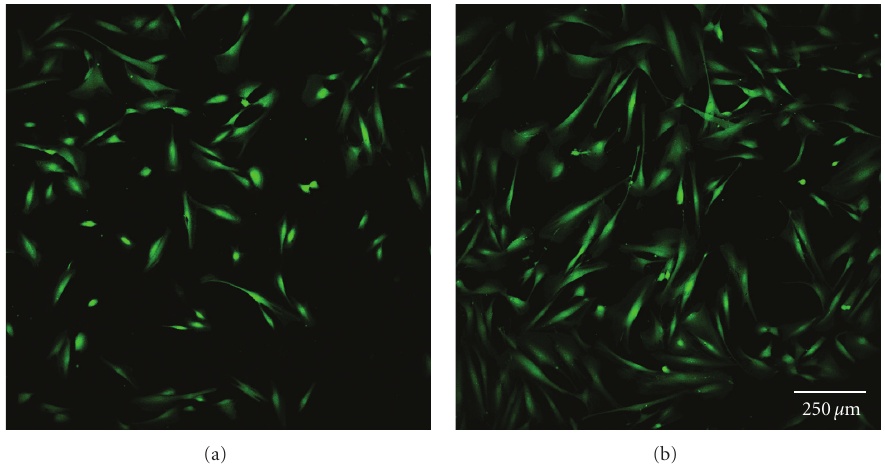
Figure 4: Fibroblast cells cultured on glass discs coated with hexylated polymer after 24 h (a) and 72 h (b).